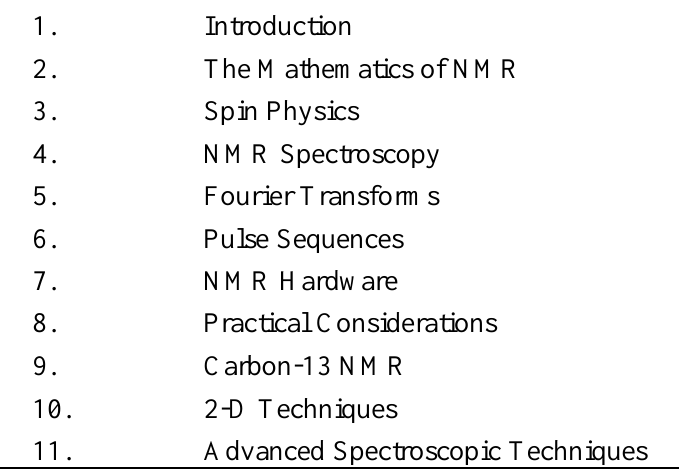
Table 1. Chapters in The Basics of NMR.